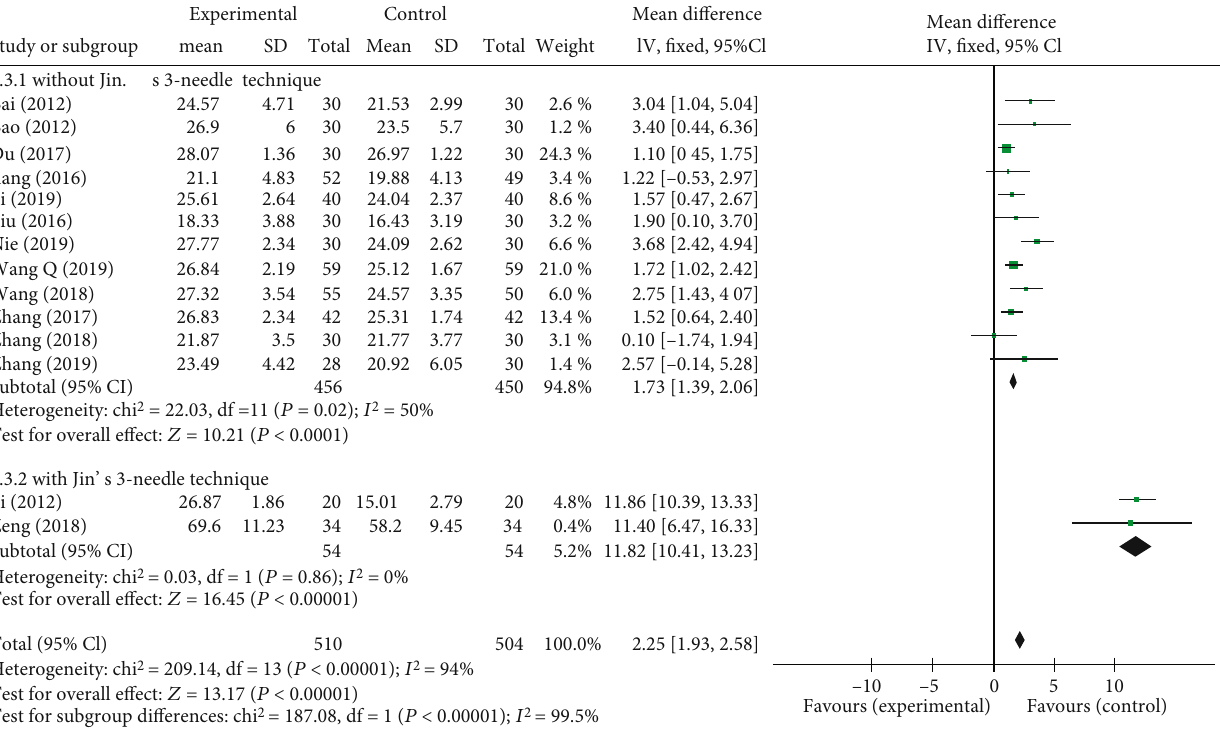
Figure 4: The forest plots of MMSE (subgroup: with or without Jin 3-needle technique). Study or subgroup